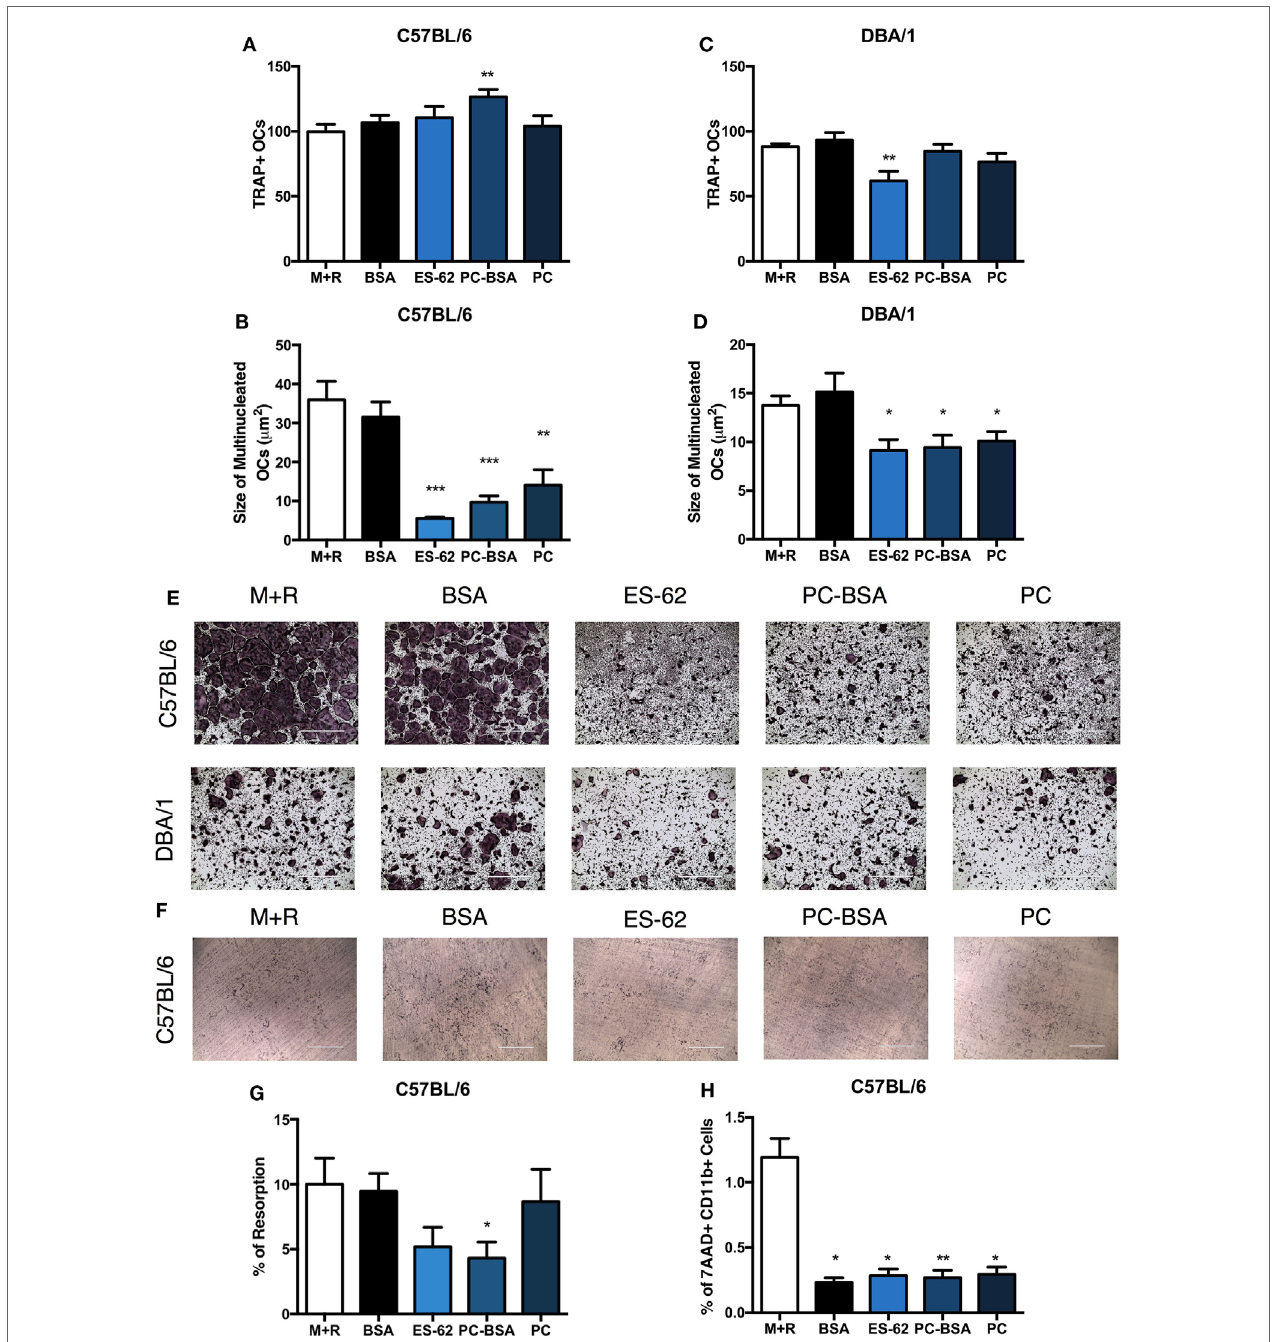
FigUre 3 | ES-62, and PC inhibit the fusion of OCs in vitro . Non-adherent bone marrow (BM), from healthy naïve C57BL/6 and DBA/1 mice was harvested and cultured for 4 days with 30 ng/ml M-CSF and 50 ng/ml RANKL, at which point, medium was removed and cells were incubated in fresh medium or medium containing 50 µg/ml of ES-62, PC, PC conjugated to BSA (PC-BSA), or BSA. OC differentiation at day 5 was assessed by TRAP staining and ImageJ was employed to measure the number and size of multinucleated OCs with > 3 nuclei present (a–D) . Representative images of experimental conditions are provided [ (e) scale bar = 1,000 µm]. To assess the ability of ES-62 to inhibit OC bone resorption, naïve C57BL/6 non-adherent BM was cultured on dentine slices with BSA, ES-62, PC-BSA, or PC treatment commencing from day 4 until day 14 when resorption was assessed and representative images are provided [ (F,g) scale bar = 400 µm]. The effect following 24 h pre-treatment of ES-62, BSA, PC-BSA, or PC on cell viability was assessed using 7AAD + CD11b + cells by flow cytometry (h) . Data are pooled from four [ (a–D) ; ES-62 treatment was only performed in two of these experiments]; two [ (g) : ES-62 treatment reduced the capacity of the cells to resorb bone in both experiments but this inhibition was only significant compared to the control cells in one experiment]; or three (h) independent experiments performed in triplicate and presented as mean ± SEM. Data were analyzed using one-way ANOVA with Fisher’s LSD post-test to compare experimental conditions to M + R, where * p < 0.05, ** p < 0.01, and *** p < 0.001.